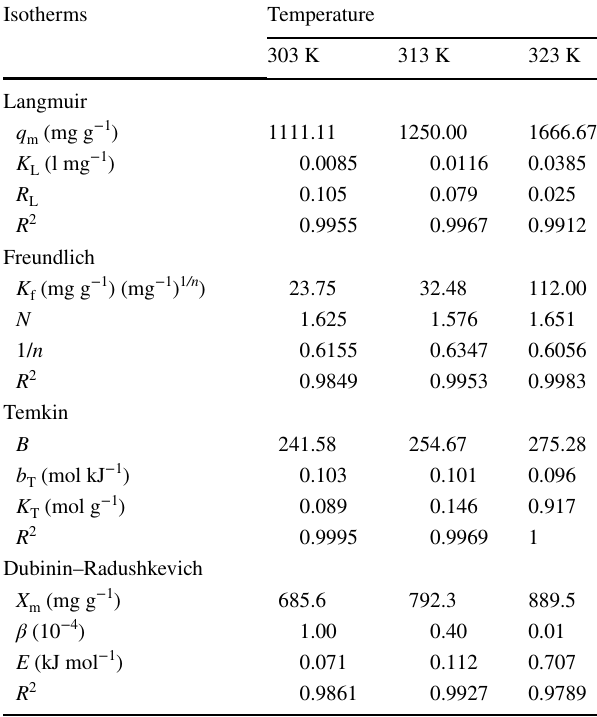
Table 5 Isotherm parameters for Rh-B dye adsorption onto CHA at different